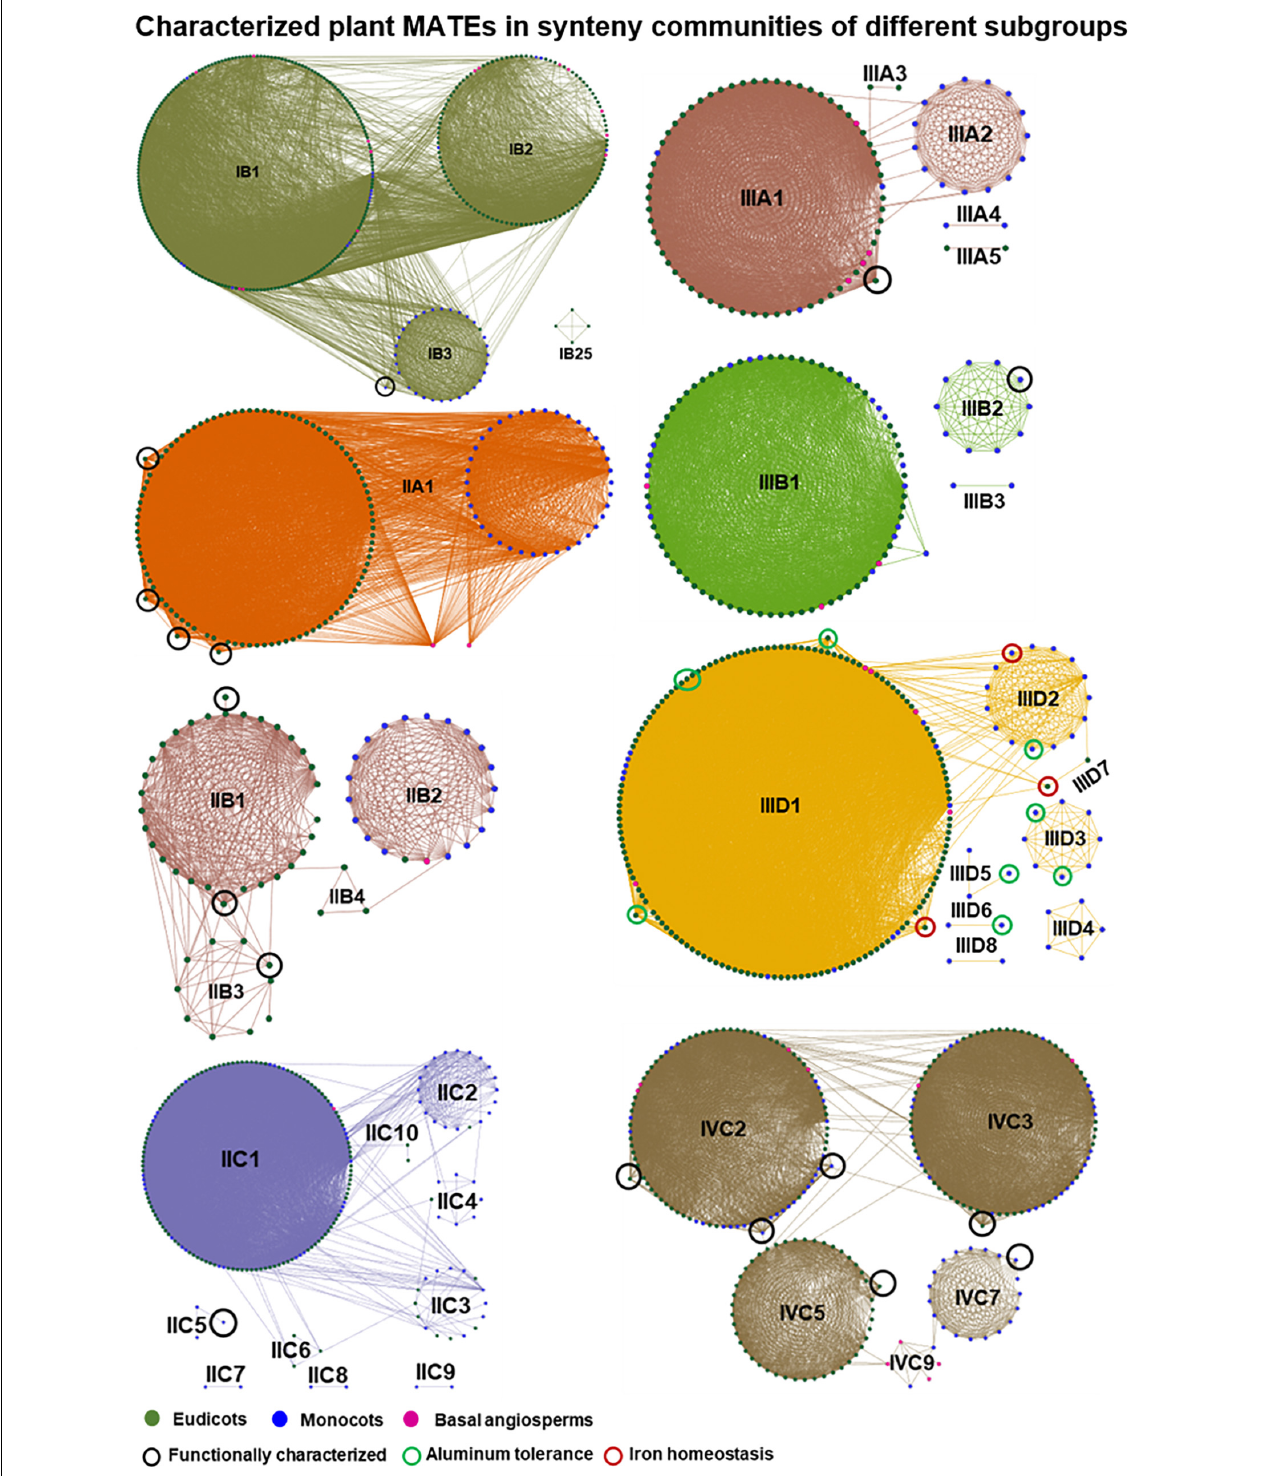
FIGURE 6 | Characterized plant MATE transporters in synteny communities of different identified subgroups. Green, blue, and pink nodes represent different species of eudicot, monocot, and basal angiosperm lineages, respectively. Characterized MATEs were inferred from Supplementary Table 5 and are highlighted with a black circle in all subgroups except IIID. Green and brown circles in subgroup IIID indicate that the MATEs are characterized for aluminum tolerance and iron homeostasis, respectively. Lines connecting the nodes denote pairwise synteny relationships. Subgroups are highlighted in different colors.